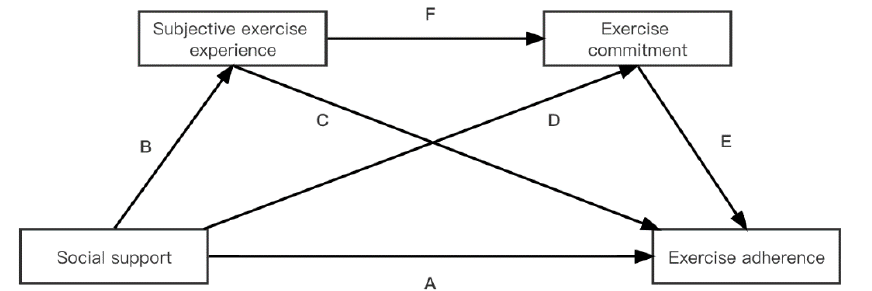
Figure 1. The hypothesis model. Hypothesis 1: A; hypothesis 2: B and C; hypothesis 3: D and E; hypothesis 4: B, F, and E.